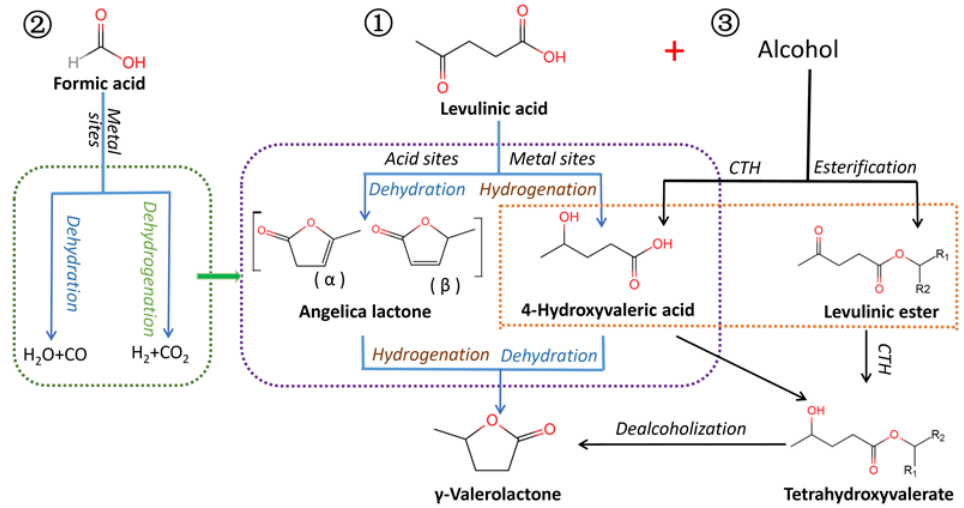
Figure 1. Reaction pathways for LA hydrogenation to GVL when different hydrogen donors are involved.